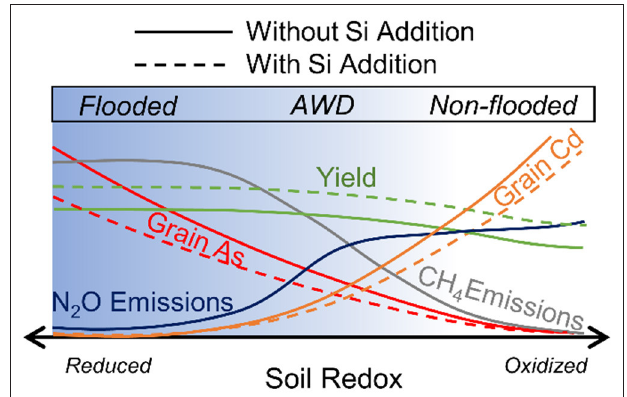
FIGURE 2 | Conceptual plot of the effect of soil redox on biogeochemistry in rice paddies; y -axis is conceptual and normalized for each term’s magnitude. Flooded rice creates reduced conditions that are conducive to high methane emissions and high grain As, while moving toward non-flooded rice increases grain Cd and N 2 O emissions. Si-rich soil amendments can decrease As and Cd in grain while also improving yield in some situations, as increased plant Si helps alleviate biotic and abiotic stresses in